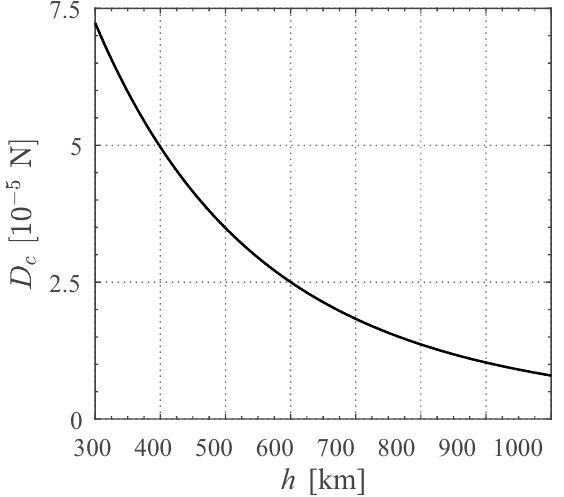
Figure 6. Approximate variation of the PB-induced Coulomb drag magnitude D c as a function of the spacecraft altitude h . A mean solar activity is assumed.